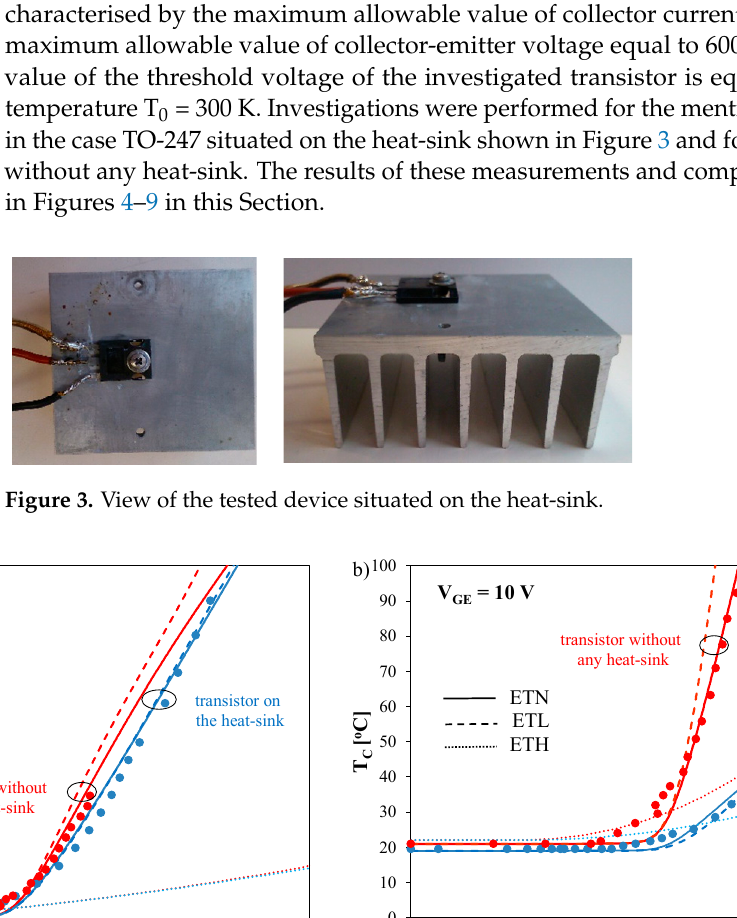
Figure 5. Computed and measured transfer characteristics of the tested transistor. The characteristics I C (V GE ) obtained at different cooling conditions of the transistor differ in shape. For the transistor situated on the heat-sink, the measured dependence I C (V GE ) is an increasing function. In turn, the characteristic for the transistor without any heat-sink shows a negative slope at current I C > 0.2 A. This non-typical shape of the con- sidered characteristic results from a rise of internal temperature of the transistor and a fall in the value of its threshold voltage. At current I C = 1 A voltage, V GE decreases even by 0.5 V as a result of changes of the cooling conditions, causing an increase in the case temper- ature T C even by 85 °C. The characteristics obtained with the Hefner model are practically the same for both types of the cooling conditions and they do not change with temperature T C due to neglecting the sub-threshold effect in this model. For the ENL model, the value of temperature T C is overestimated and the characteristics I C (V GE ) show a shift to the left and differ visibly from the measurement results. The differences in the measured and computed with the ETN model values of V GE voltage do not exceed 0.1 V, whereas for the